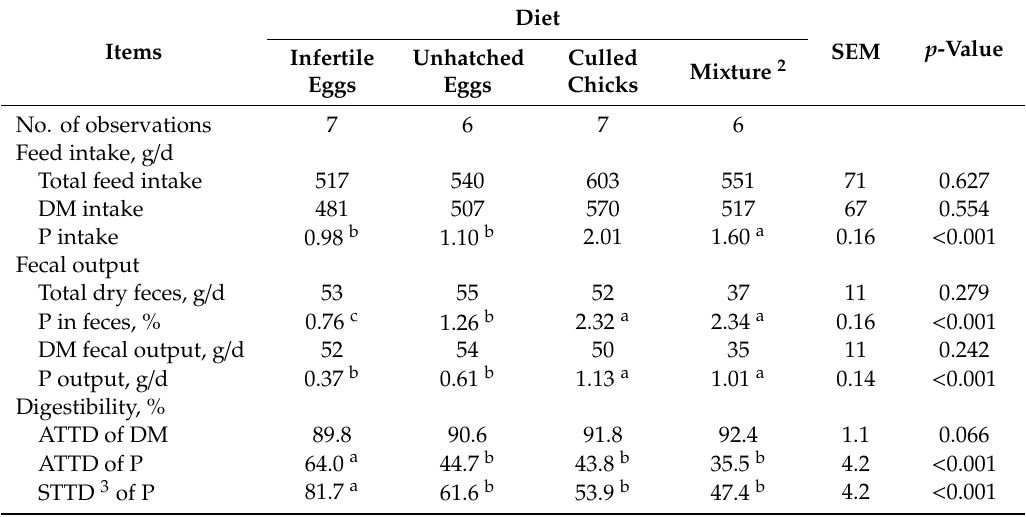
Table 6. Digestibility of dry matter (DM) and phosphorus (P) in hatchery byproducts fed to nursery pigs (Experiment 2) 1